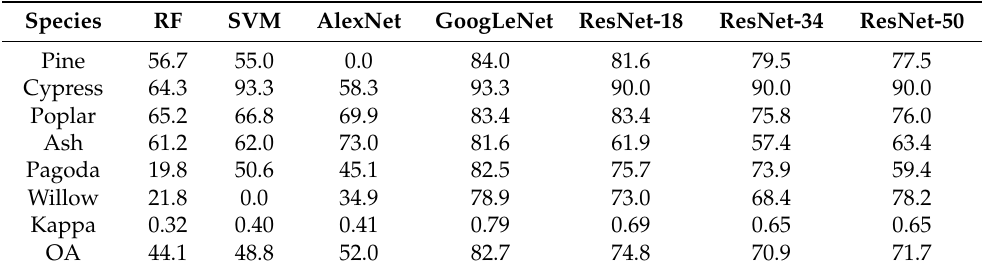
Table 9. Classification accuracies for six tree species using RF, SVM, AlexNet, GoogLeNet, and ResNet. All values except for kappa coefficient, are